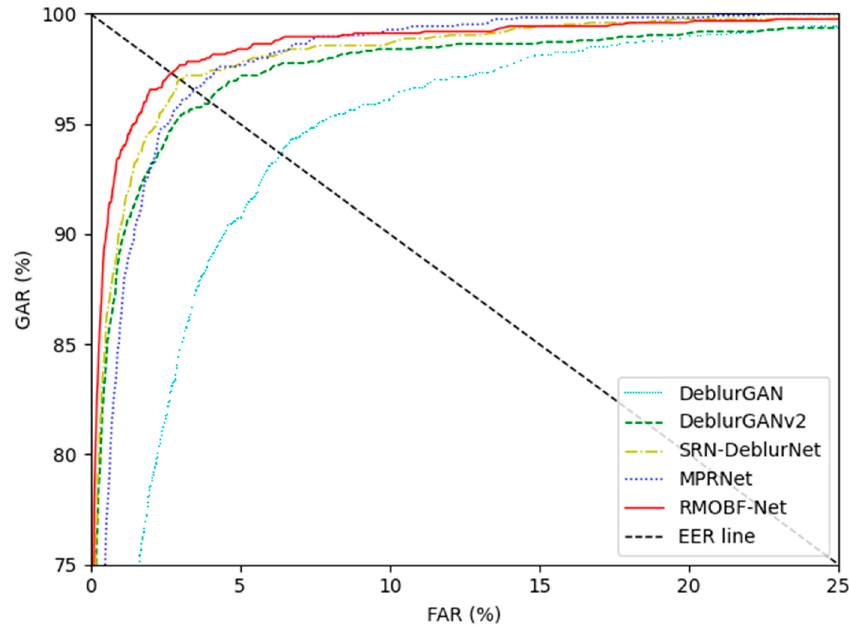
Figure 30. ROC curves of finger-vein recognition with PolyU-DB for scheme 4 by various restoration methods (random motion blur and optical blur with intensity 11 × 11 (Gaussian filter size) and 11 (Gaussian filter standard deviation)).